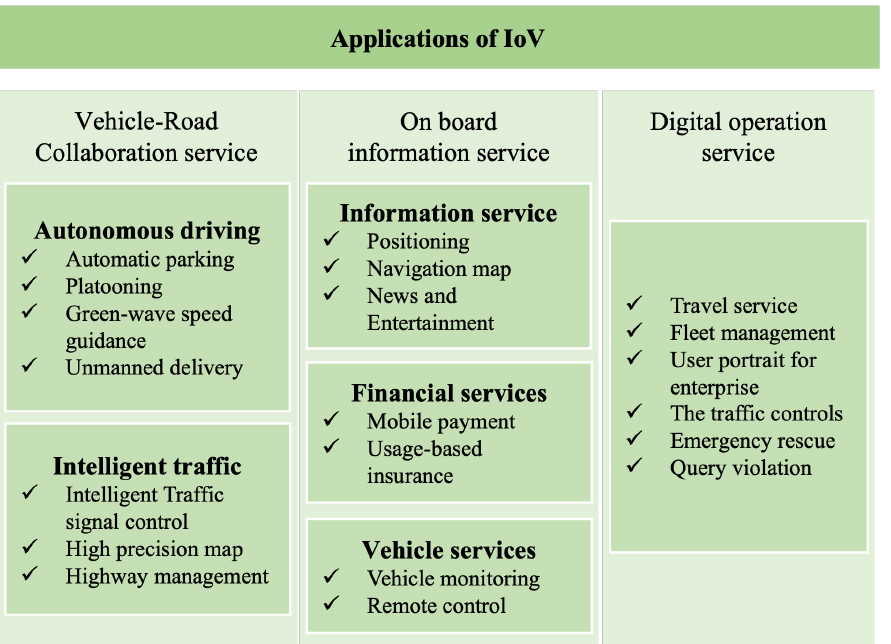
Figure 1. Application of Internet of